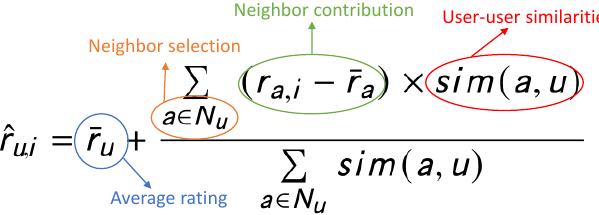
Figure 1. Four components in